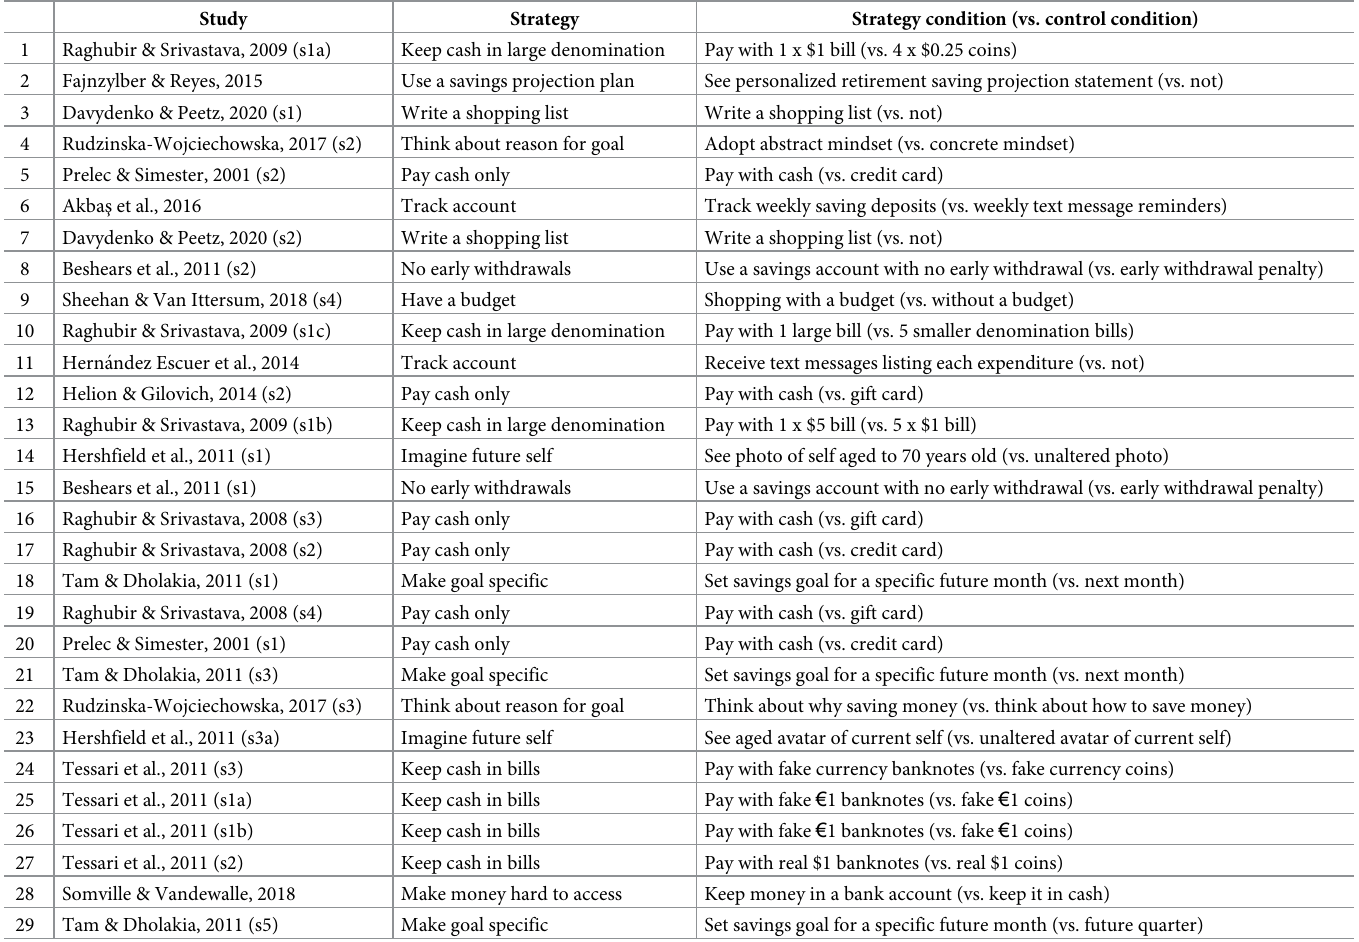
Table 1. Studies included in the meta-analysis, in order of effect size of the financial self-control